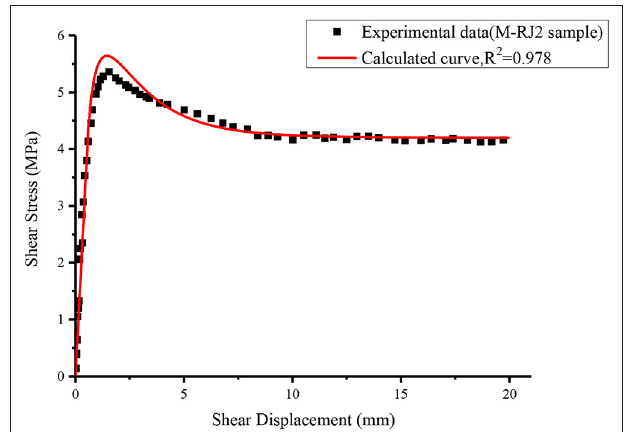
FIGURE 5 | Comparison between the calculated curve of proposed model and experimental result (M-RJ2 sample).